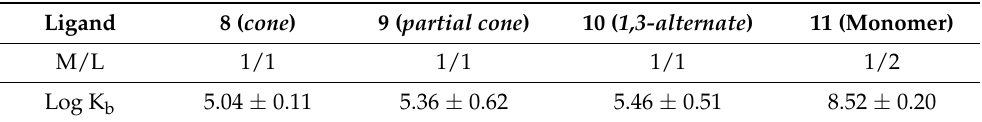
Table 1. Binding constants (log K b ) for copper (II) complexes of the compounds 8 – 11 in the CH 3 OH/CHCl 3 (1:1) mixture at room temperature.